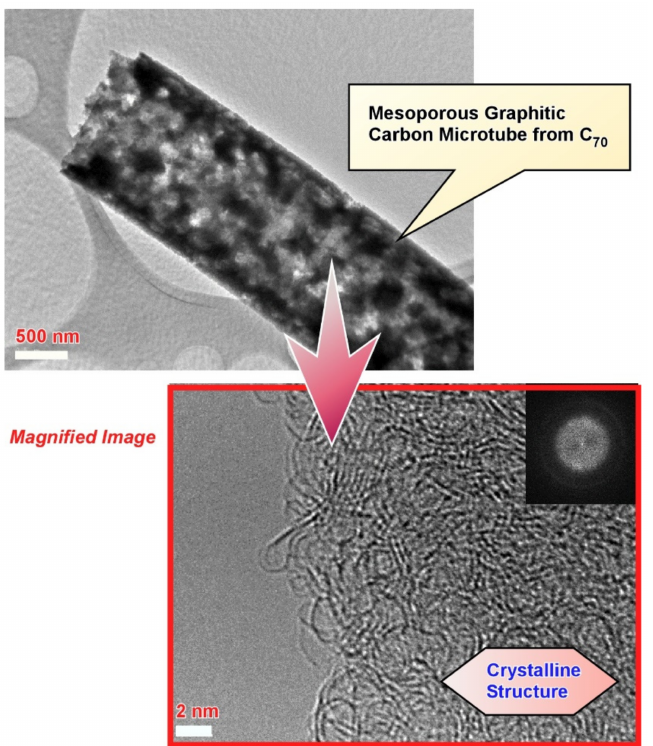
Figure 7. Mesoporous graphitic carbon microtubes fabricated from mesoporous crystalline fullerene (C 70 )